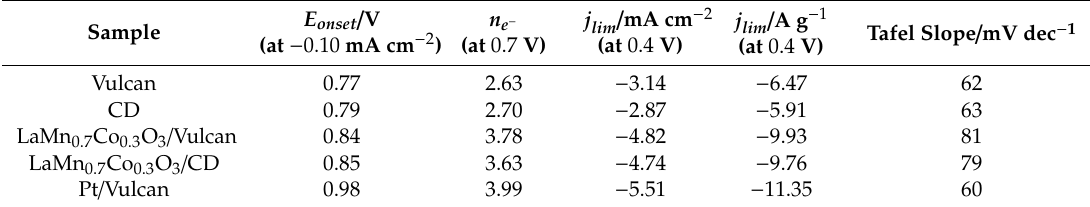
Table 4. Onset potential, number of electrons, and limiting current obtained for the ORR reaction at di ff erent carbon materials and LaMn 0.7 Co 0.3 O 3 / carbon materials (1:1 mass ratio).